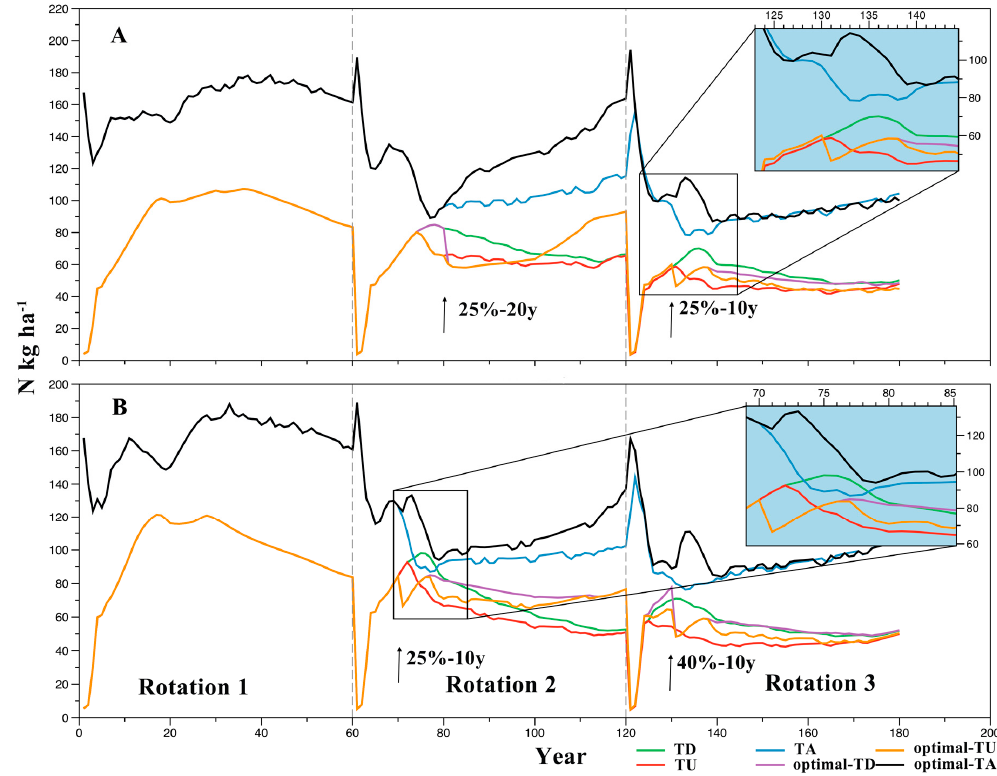
Figure 5. Change in ecological variables in stands with different initial densities in 180 years of simulation under different thinning treatments and non-thinning. Panel A: 3000 stems ha − 1 , Panel B: 4000 stems ha − 1 , TD—total demand N; TU—total uptake N; TA—total available N in soil; optimal-TD—total demand N under optimal treatments; optimal-TU—total uptake N under optimal treatments; optimal-TA—total available N under optimal treatments.